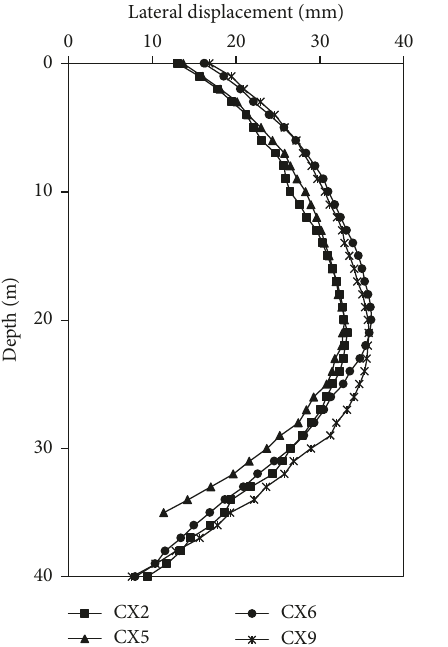
Figure 10: Curves of lateral displacement versus depth for different monitoring points.